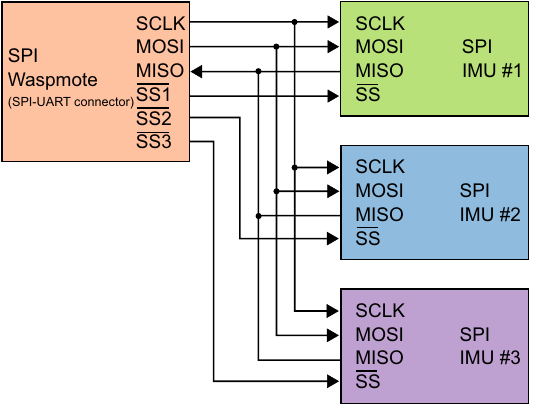
Figure 10. SPI bus implementation to interconnect the inertial sensors block and the main